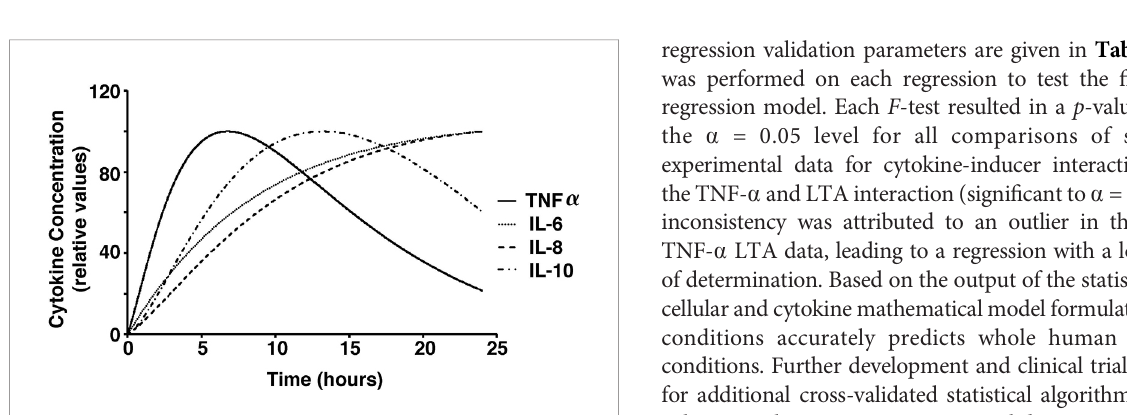
FIGURE 5 | Cytokine concentrations over a 24-hour period in response to stimulations with low dose S. aureus in our